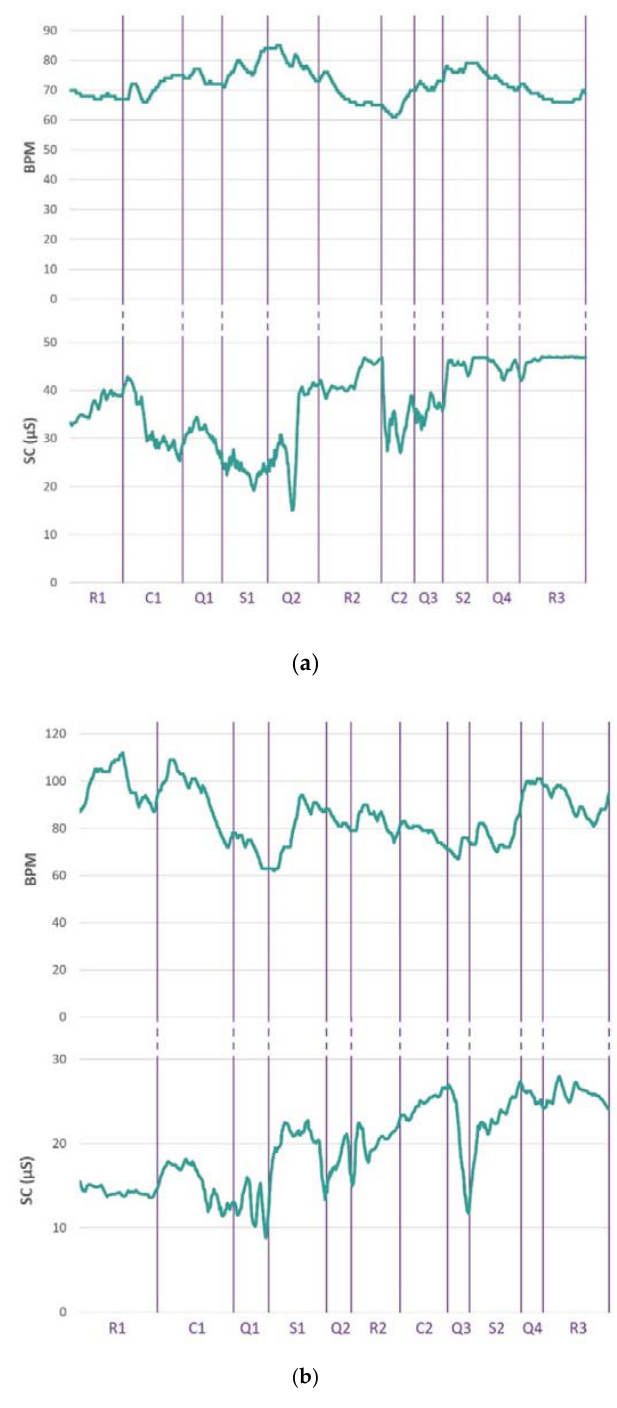
Figure 11. The evolution of BPM and SC values during the experimental procedure. Resting periods (R1, R2, R3), control periods (C1, C2), stress periods (S1, S2) and self-report questionnaire completion periods (Q1, Q2, Q3, Q4) are marked. All periods are presented in the order in which they were performed. The time intervals C1, Q1, S1 and Q2 correspond to the Stroop Color Word Task, while C2, Q3, S2 and Q4 correspond to the Mental Arithmetic Task. ( a ) BPM and SC values for subject A; ( b ) BPM and SC values for subject